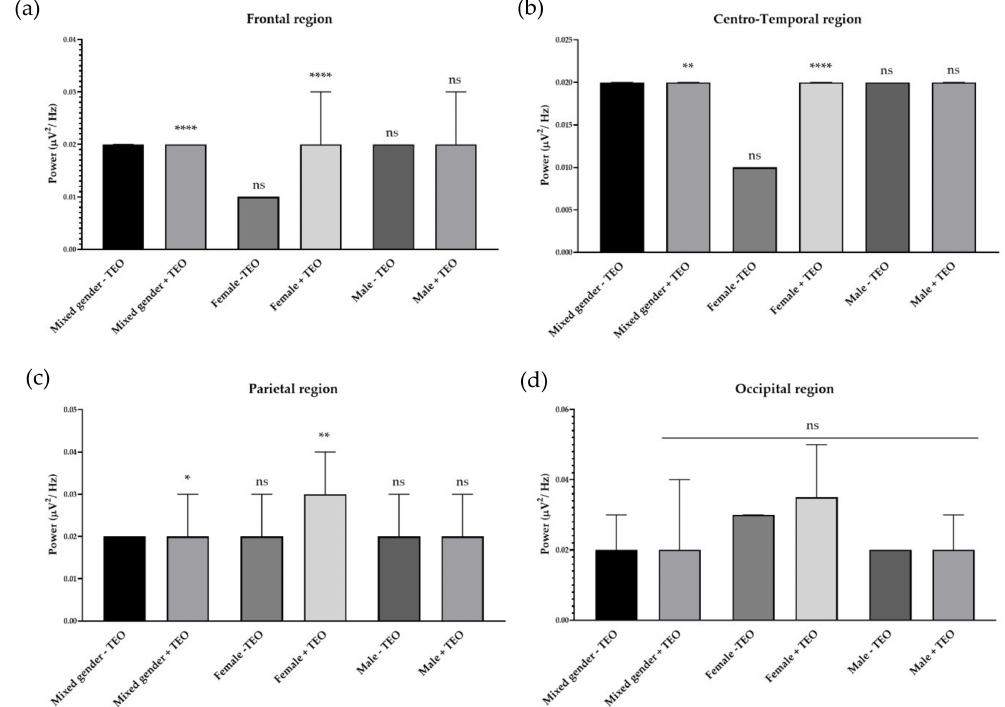
Figure 5. E ff ects of tangerine essential oil on low beta (14 Hz): ( a ) Frontal region; ( b ) Centro-Temporal region; ( c ) Parietal region; ( d ) Occipital region. p value: ns ≥ 0.05, * < 0.05, ** < 0.01, **** < 0.0001.